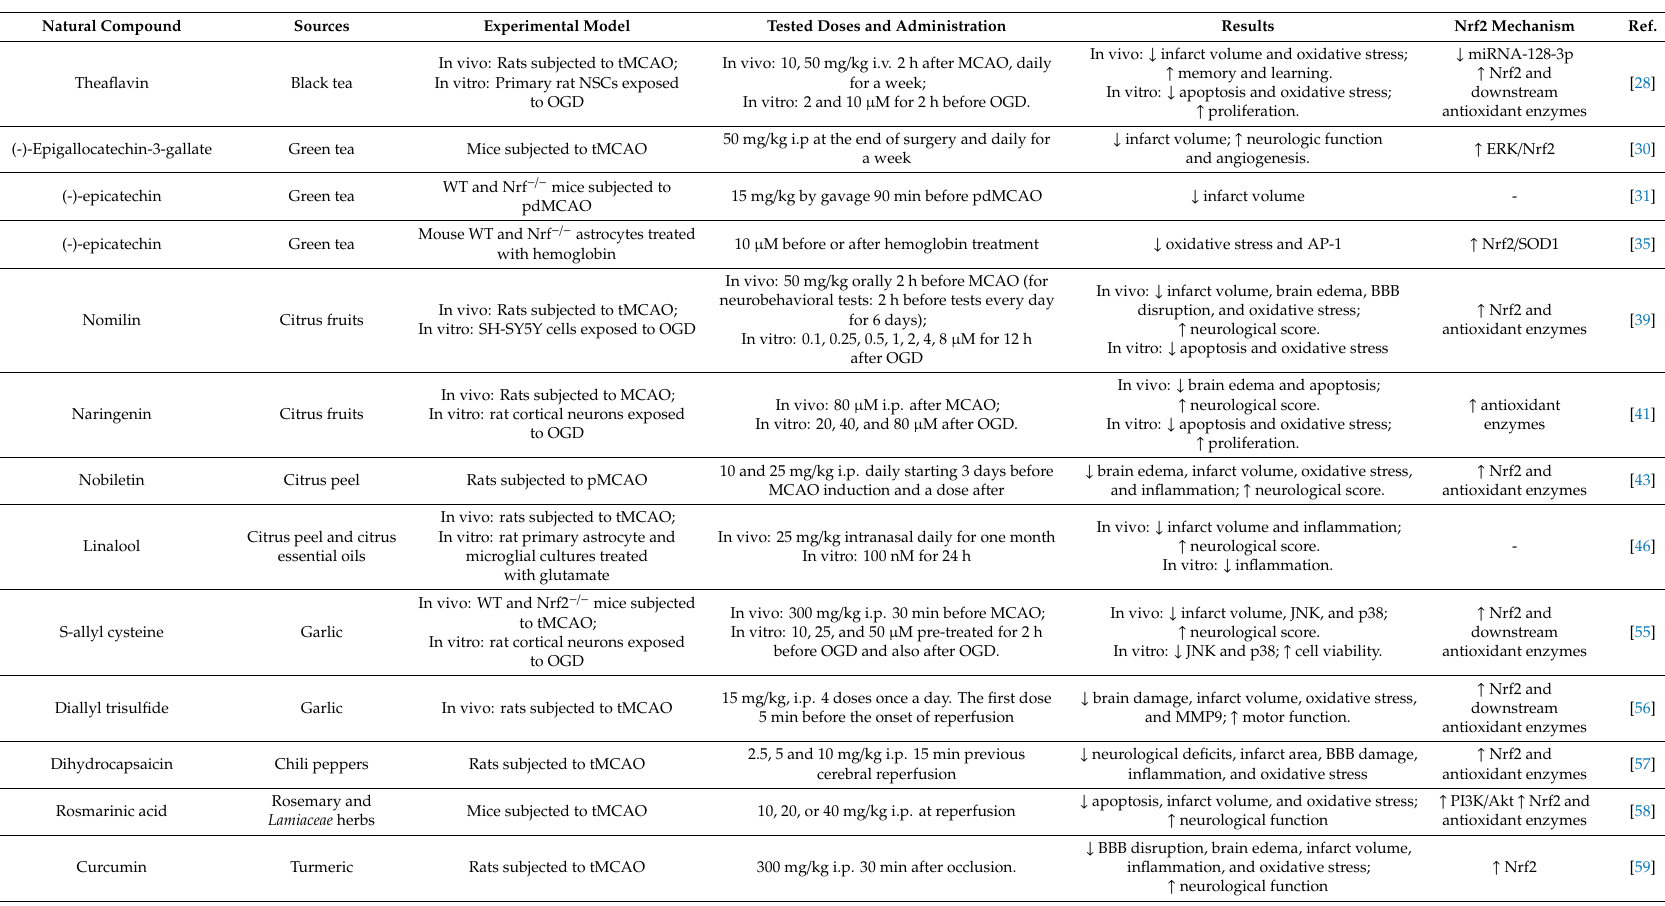
Table 1. Summary of the experimental studies involving natural compounds able to modulate Nrf2 pathway in in vivo stroke models. Natural Compound